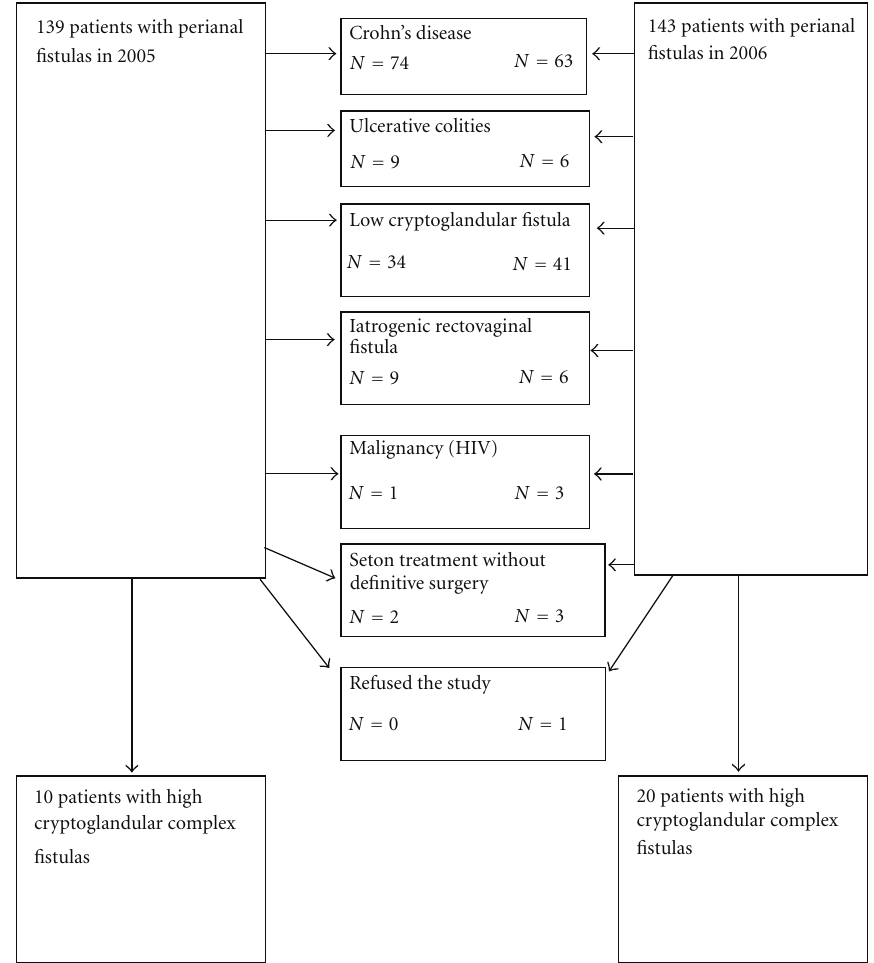
Figure 1: Flow chart of patients with perianal fistulas treated in the Academic Hospital of Maastricht between 2005 and